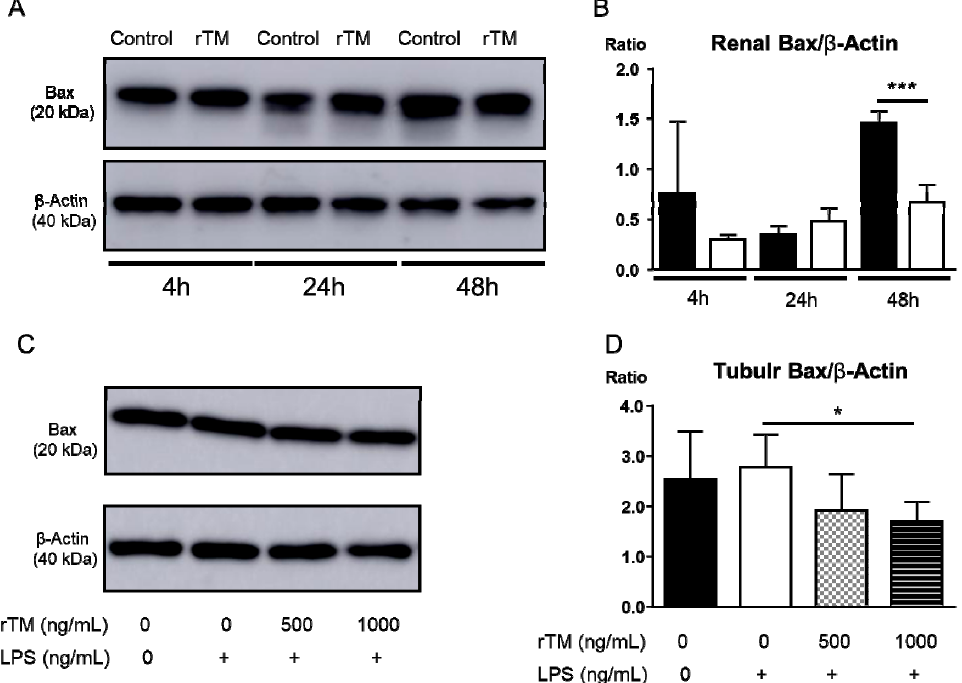
Figure 7. Expression of Bax in the kidney and tubular epithelial cells by Western blotting in vivo and in vitro. Representative photographs show Bax expression in the kidney and tubular epithelial cells (TECs) ( A , C ). The ratio of Bax/ β -actin in the kidney after lipopolysaccharide (LPS) injection was analyzed at 4, 24, and 48 h ( B ). The ratio of Bax/ β -actin in the TECs added with rTM (0, 500, and 1000 ng/mL) in the presence of LPS (300 ng/mL) was analyzed for 24 h (each goup; n = 4) ( D ). The data are the mean ± standard error of the mean (*** p < 0.001 , control versus rTM-treated mice and * p < 0.05 , LPS 300 ng/mL alone versus rTM 1000 ng/mL + LPS 300 ng/mL).